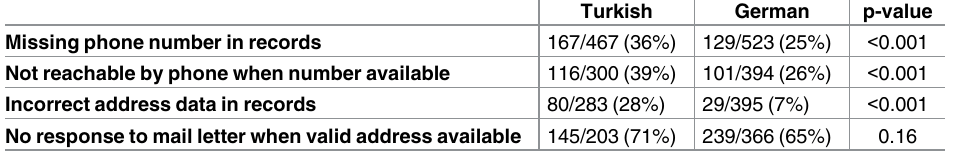
Table 2. Causes for unsuccessful contacting eligible German and Turkish patients in ambulatory practicesby telephone and